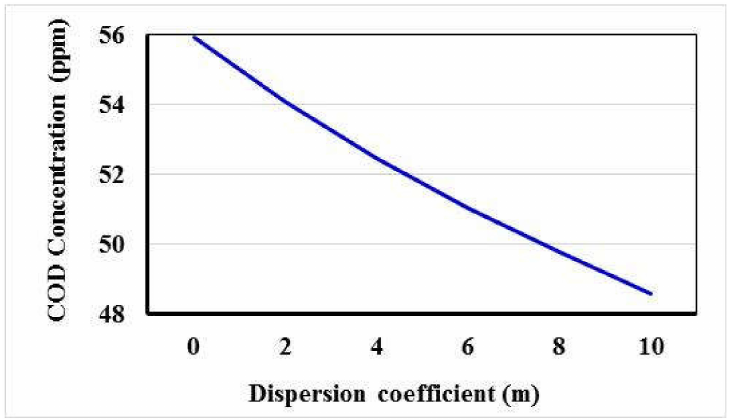
Figure 5. Relationship between COD concentration and dispersion